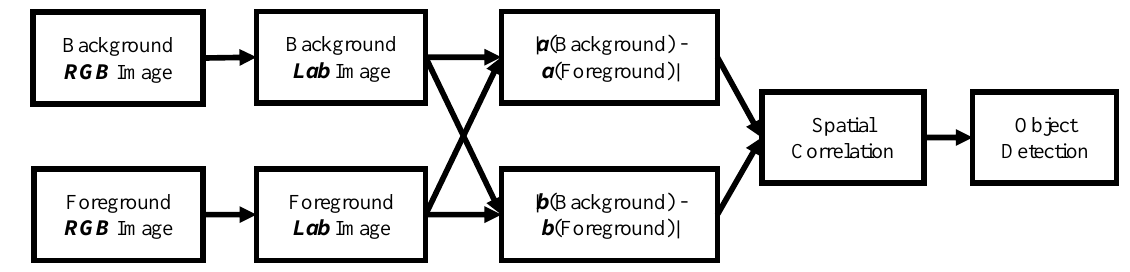
Figure 1. Moving object detection using Lab colour space and spatial